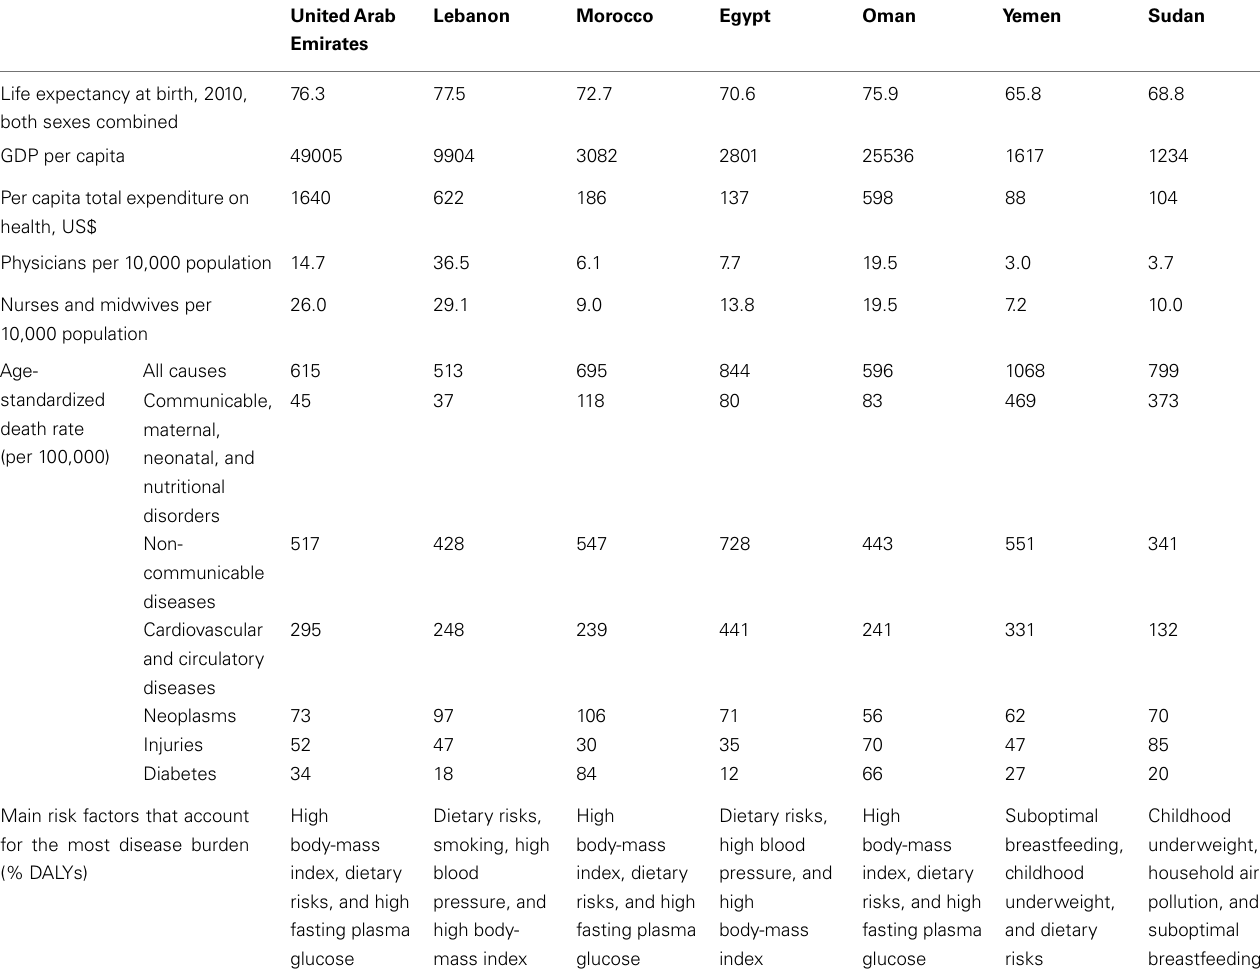
Table 2 |ArabWorld/WHO EMR, life expectancy, GDP per capita, total expenditure on health, density of physicians, nurses and midwives, standardized mortality for selected conditions, main risk factors, selected countries,